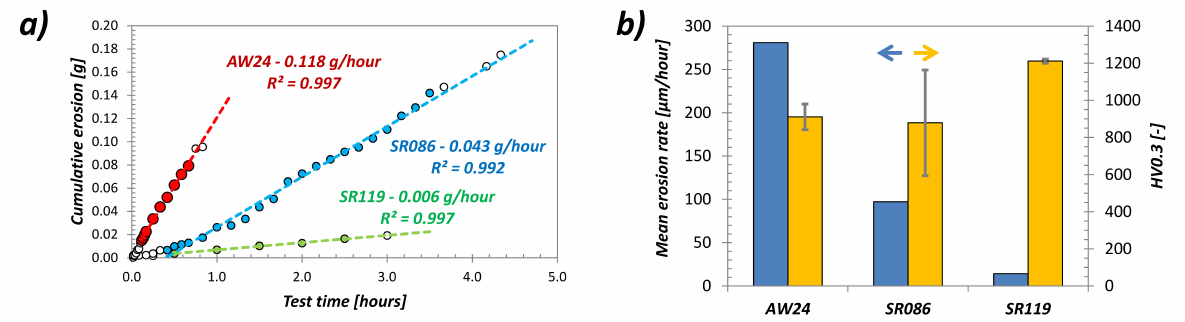
Figure 3. a) Cumulative erosion vs time curves. Filled points were used for linear fit. b) Erosion rates (blue) and coating microhardness values